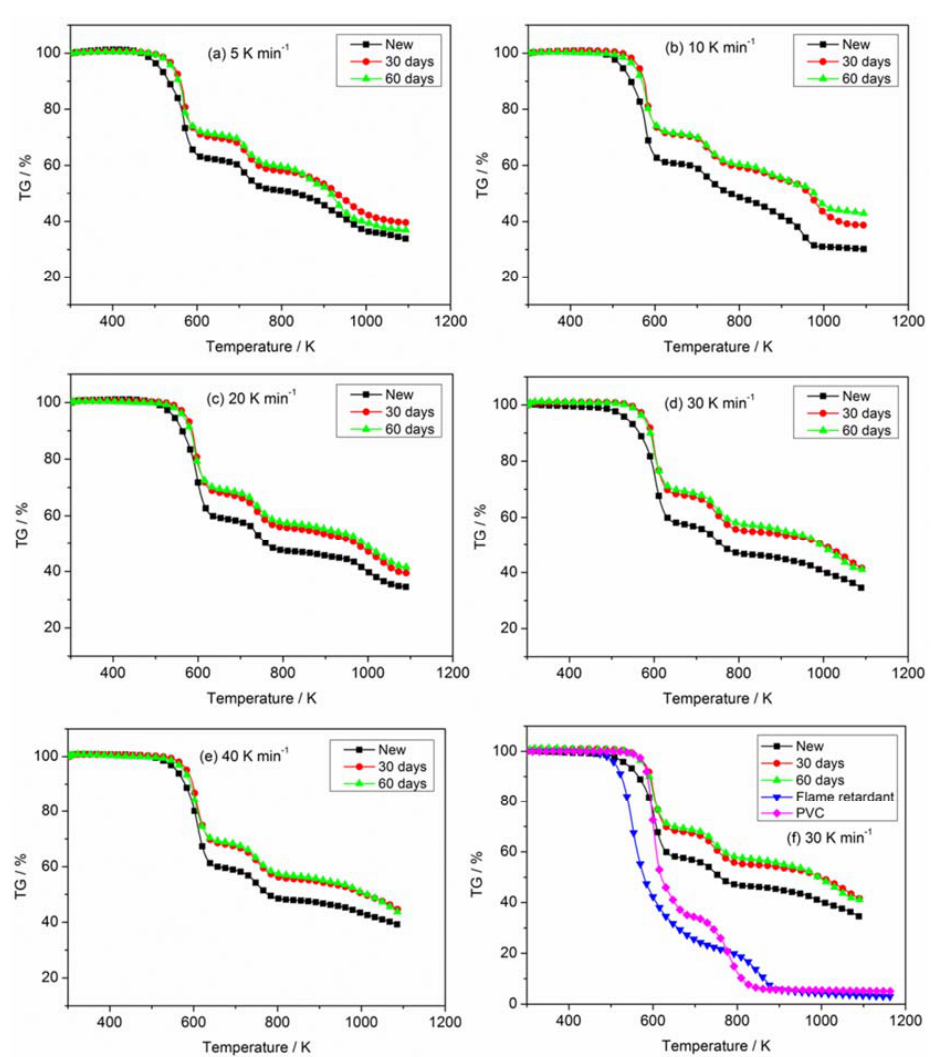
Figure 4. Comparison of TG of PVC sheaths for new and aged cables at different heating rates in nitrogen atmosphere. ( a ) 5 K min − 1 ; ( b ) 10 K min − 1 ; ( c ) 20 K min − 1 ; ( d ) 30 K min − 1 ; ( e ) 40 K min − 1 and ( f ) 30 K min − 1 involving raw materials.